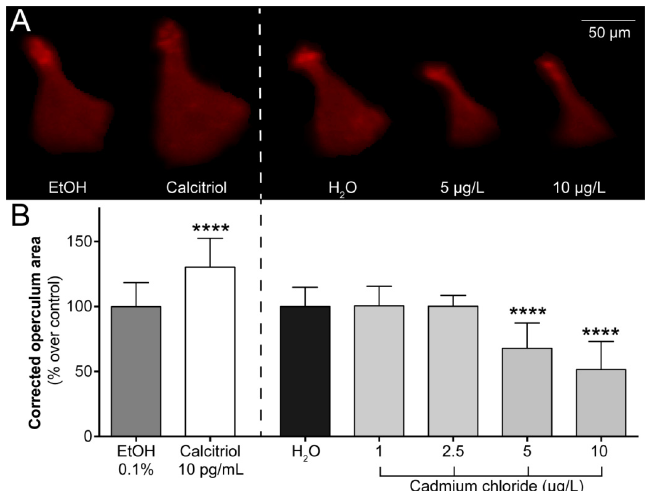
Figure 1. Effect of cadmium on the operculum growth during zebrafish development. ( A ) Fluorescence pictures of the operculum of 6-days post-fertilization (dpf) larvae exposed for 3 days to 10 pg/mL of calcitriol, 5 and 10 μ g/L of cadmium chloride, or respective vehicles, and stained with alizarin red S (AR-S). Background was removed using image processing software to highlight operculum structure. ( B ) Area of the operculum determined through morphometric analysis of AR-S stained larvae and corrected by the area of the head. Ethanol and water were used as vehicles for calcitriol and cadmium chloride, respectively. Asterisks indicate values statistically different from vehicle values (one-way ANOVA followed by Dunnett’s multiple comparison test for water and cadmium; Student’s t test for ethanol and calcitriol (**** p < 0.0001)). Values are presented as percentages over controls and are the mean ± standard deviation (n ≥ 11).